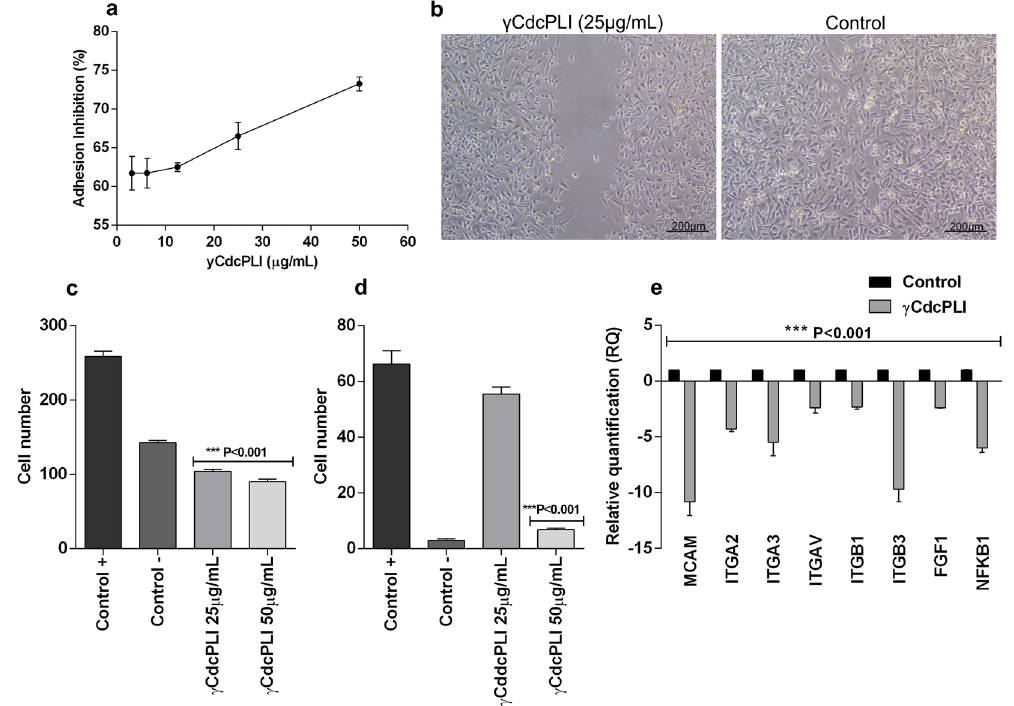
Figure 3. Anti-metastatic effect of γ CdcPLI inhibitor. ( a ) Inhibition of adhesion cell by γ CdcPLI at different concentrations (50, 25, 12.5, 6.25, 3.125 μ g/mL). ( b ) Migration analysis by Wound Healing Assay. The representative images of the wound in MDA-MB231 at 24 h after γ CdcPLI treatment (25 μ g/mL). ( c ) Inhibition of migration cells through transwell, positive control, negative control and γ CdcPLI at 25 and 50 μ g/mL. ( d ) Inhibition of invasion cells by Matrigel-transwell assay, positive control, negative control and γ CdcPLI at 25 and 50 μ g/mL. ( e ) Relative quantification of metastatic genes in MDA-MB-231 cells treated with γ CdcPLI at 25 μ g/ mL. All data are expressed as mean ± S.E.M and all assays were carried out in triplicate; differences between treatments and controls were analyzed by Unpaired t-test. Statistically significant values are represented by *** p <